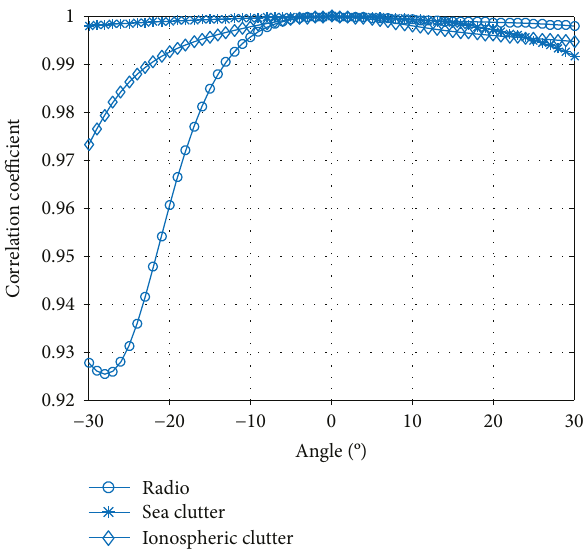
Figure 4: Correlation coe ffi cient of the measured radio and clutter.